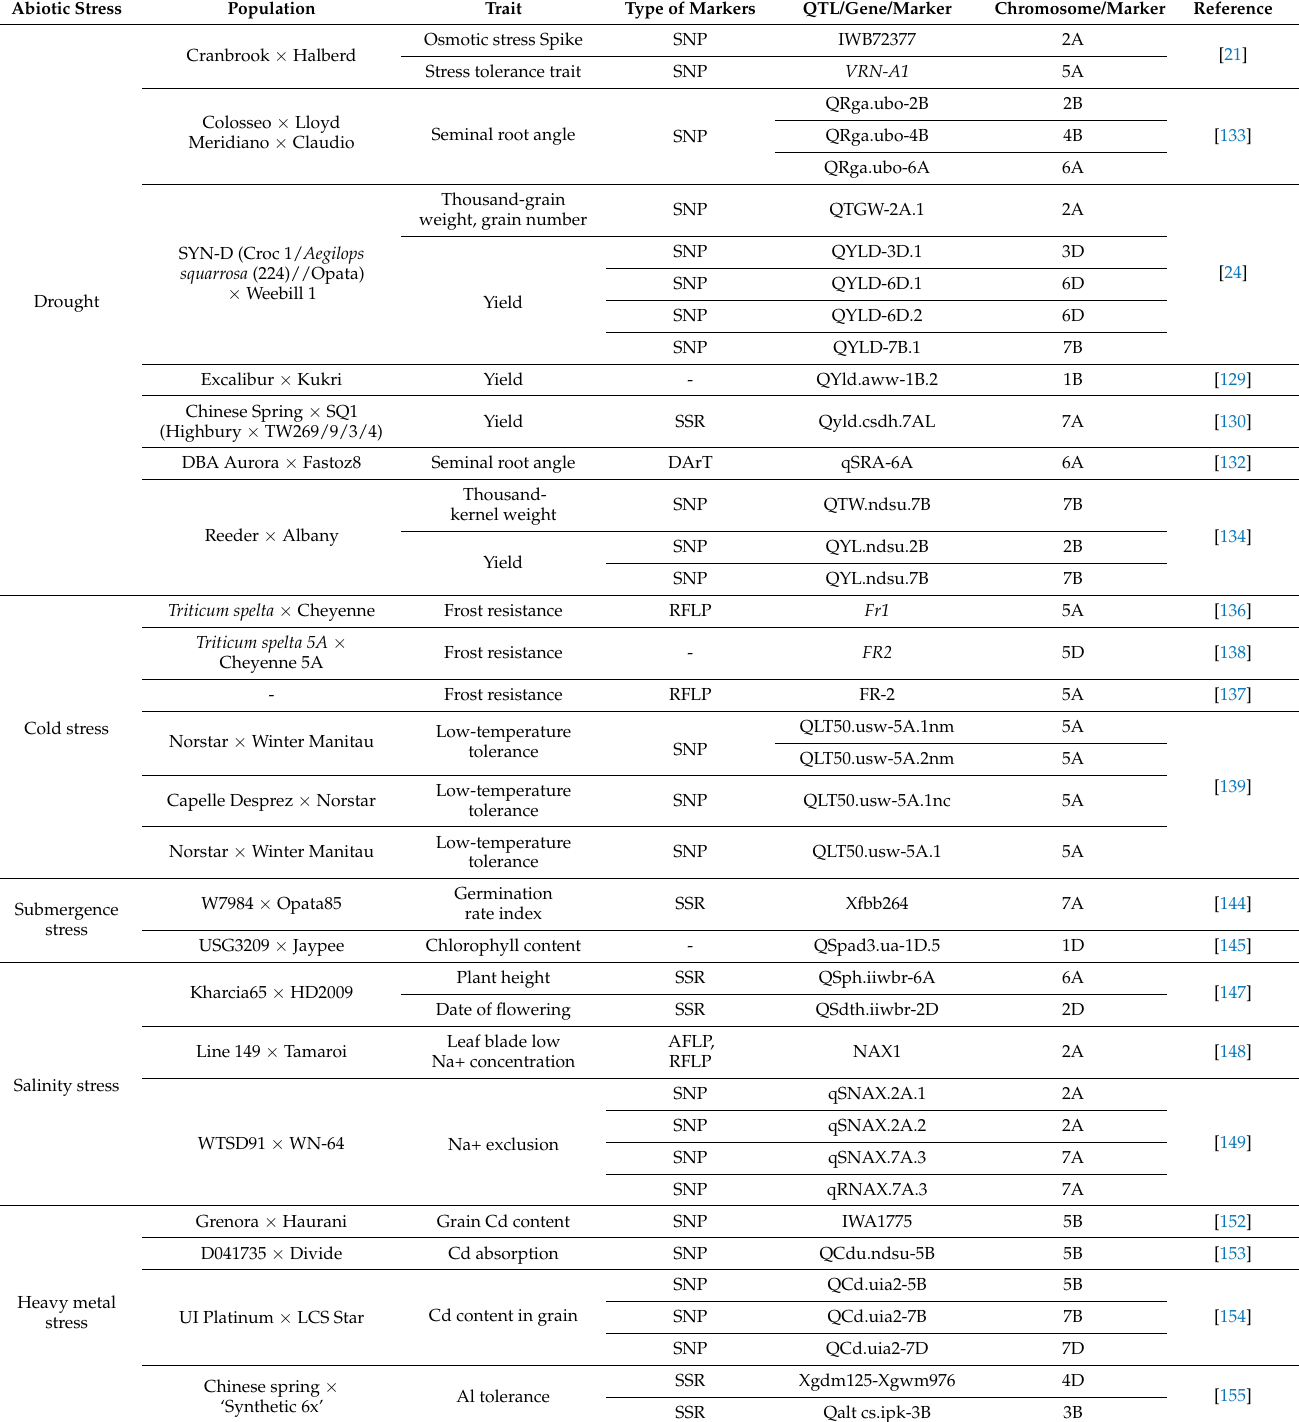
Table 3. List of QTL linked to abiotic stress tolerance in